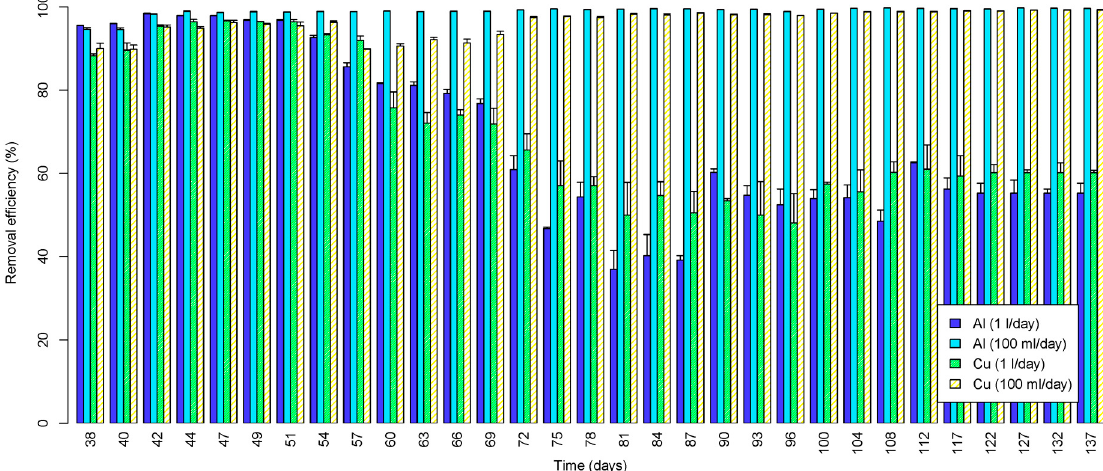
Figure 8. Al and Cu removal efficiency (%) using spent Agaricus bisporus as a function of reactor operation time.